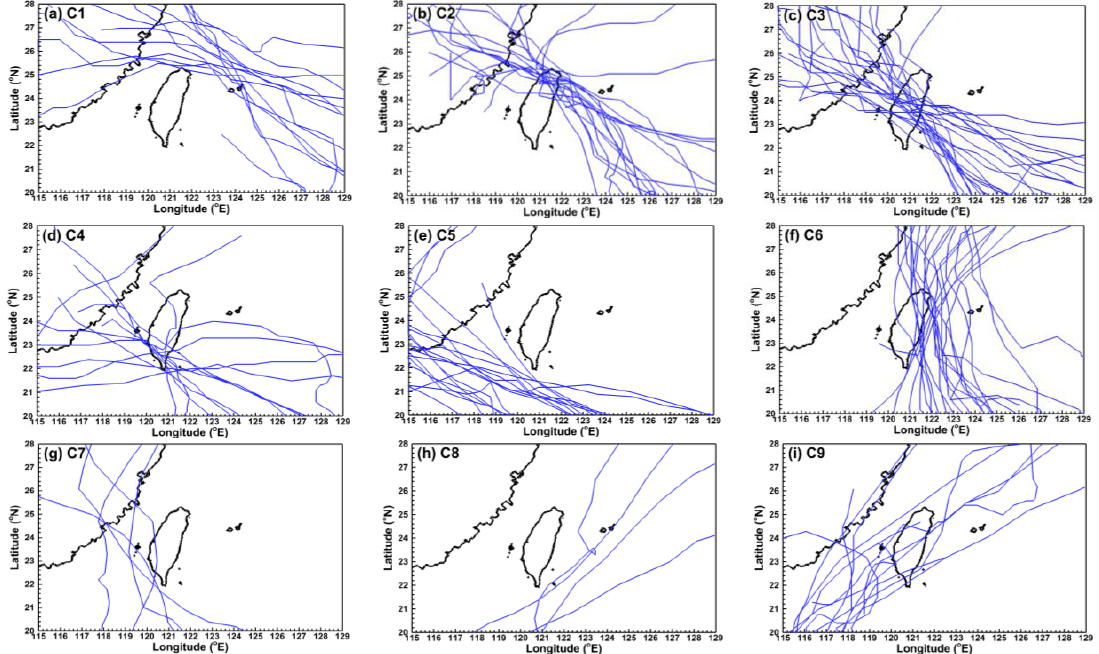
Figure 2. Tracks of historical typhoon events (blue lines) for each category during the period from 1979 to 2018. (a ) category 1, ( b ) category 2, ( c ) category 3, ( d ) category 4, ( e ) category 5, ( f ) category 6, ( g ) category 7, ( h ) category 8 and ( i ) category 9.